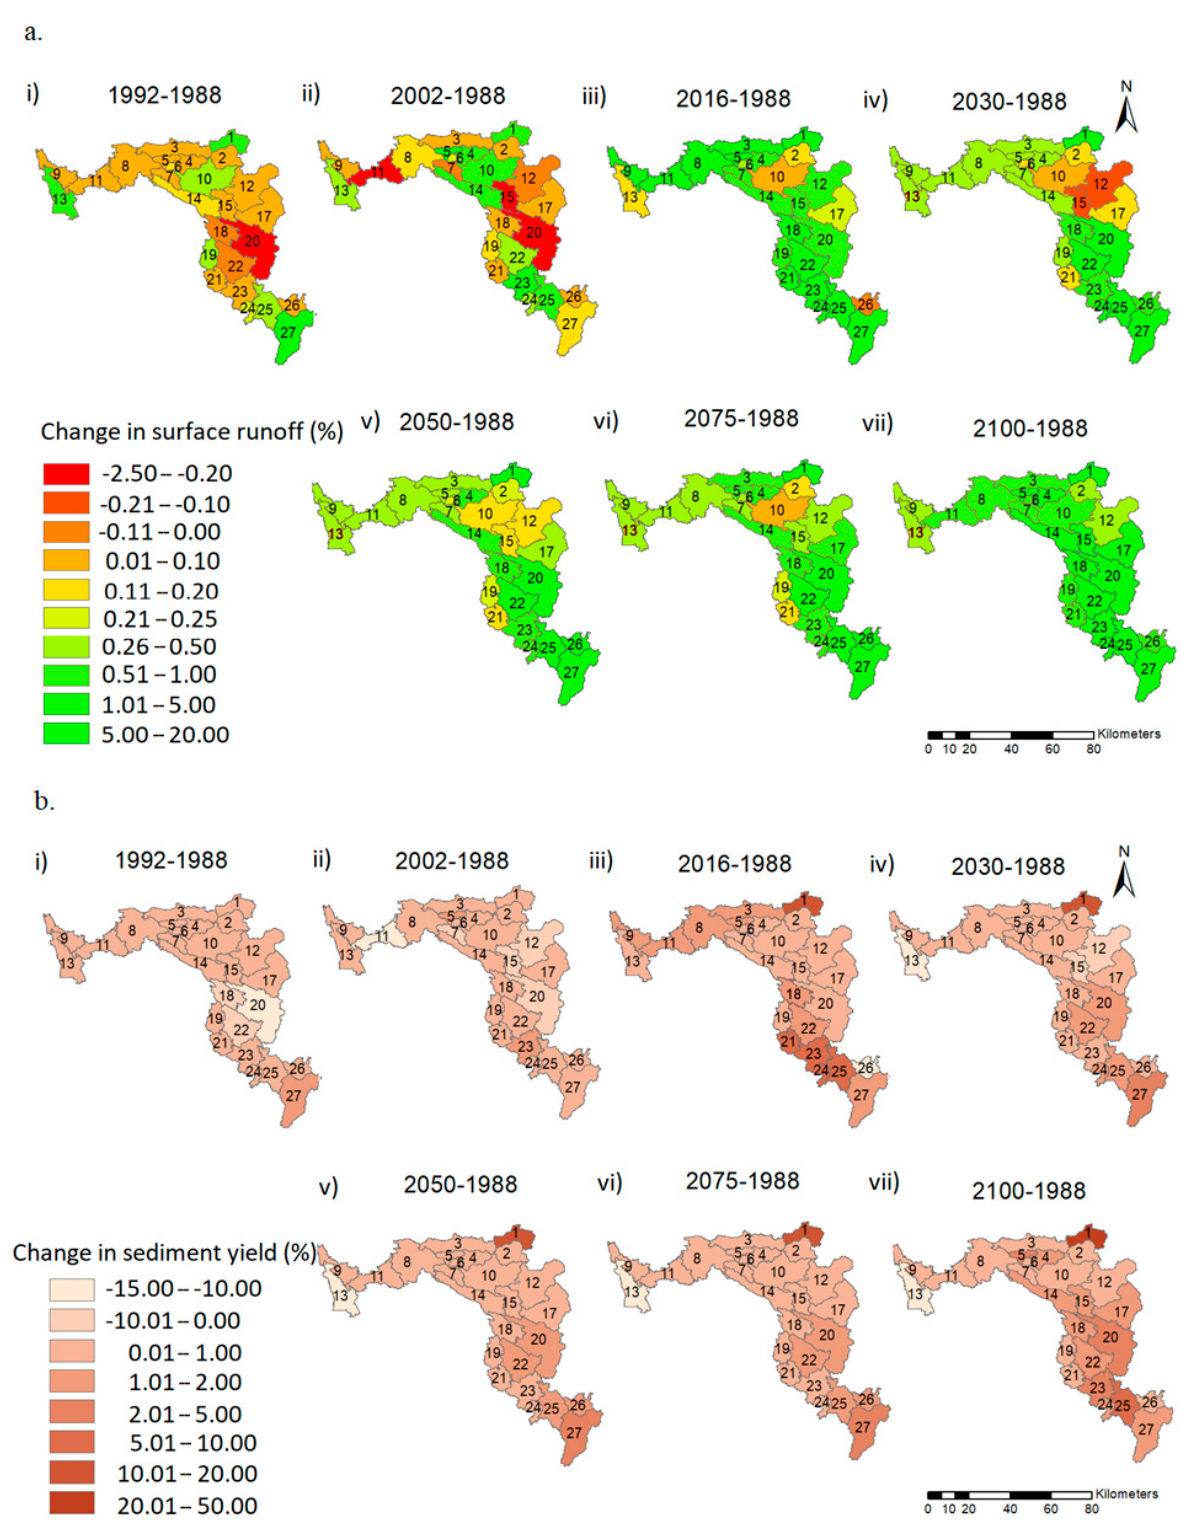
Figure 7. Spatial variation of change (%) in the ( a ) surface runoff and ( b ) sediment yield at sub- watershed outlet with varying LULC between 1988 and 2100 across the sub-watersheds (#1 to #27): ( i ) 1992-1988; ( ii ) 2002-1988; ( iii ) 2016-1988; ( iv ) 2030-1988; ( v ) 2050-1988; ( vi ) 2075-1988; and ( vii ) 2100-1988.